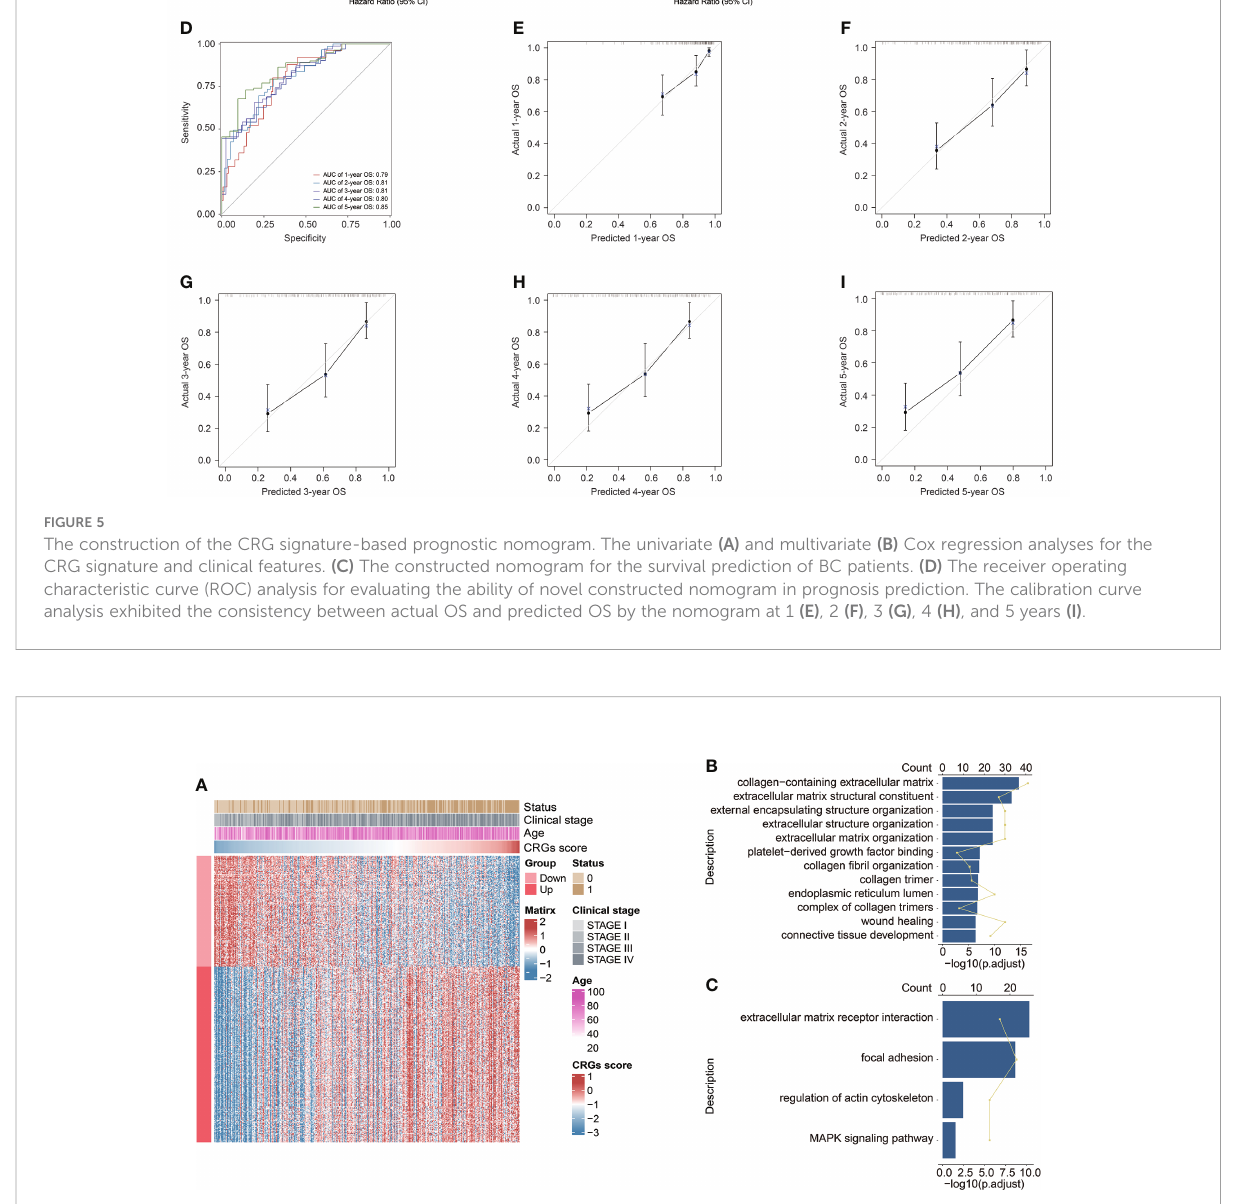
FIGURE 6 The functional enrichment analysis underlying the CRG signature. (A) The heatmap exhibited the expression levels of CRG signature-associated genes positively and negatively correlated with CRG score (|Pearson Correlation Coef fi cient| > 0.4, p < 0.05). The GO enrichment analysis (B) and KEGG pathway enrichment analysis (C) of the identi fi ed CRG signature-associated